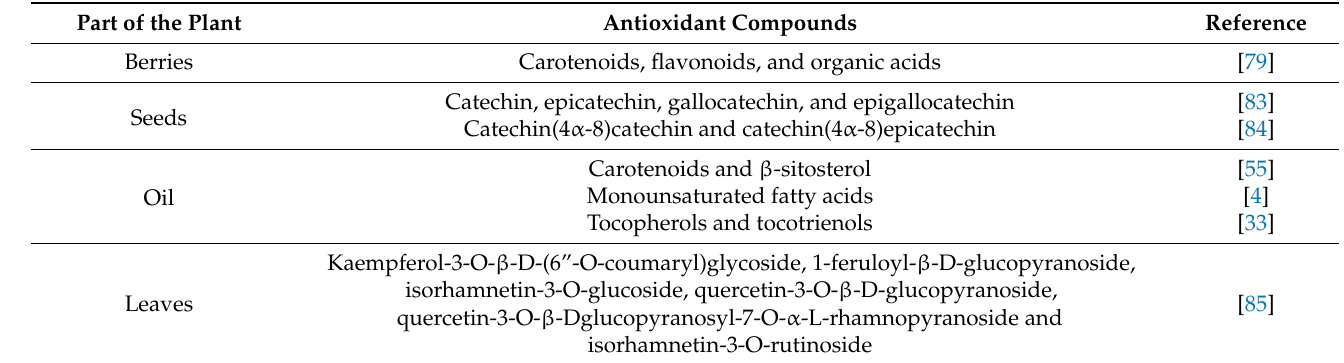
Table 5. Antioxidant compounds in sea buckthorn. Antioxidant Compounds Carotenoids, flavonoids, and organic